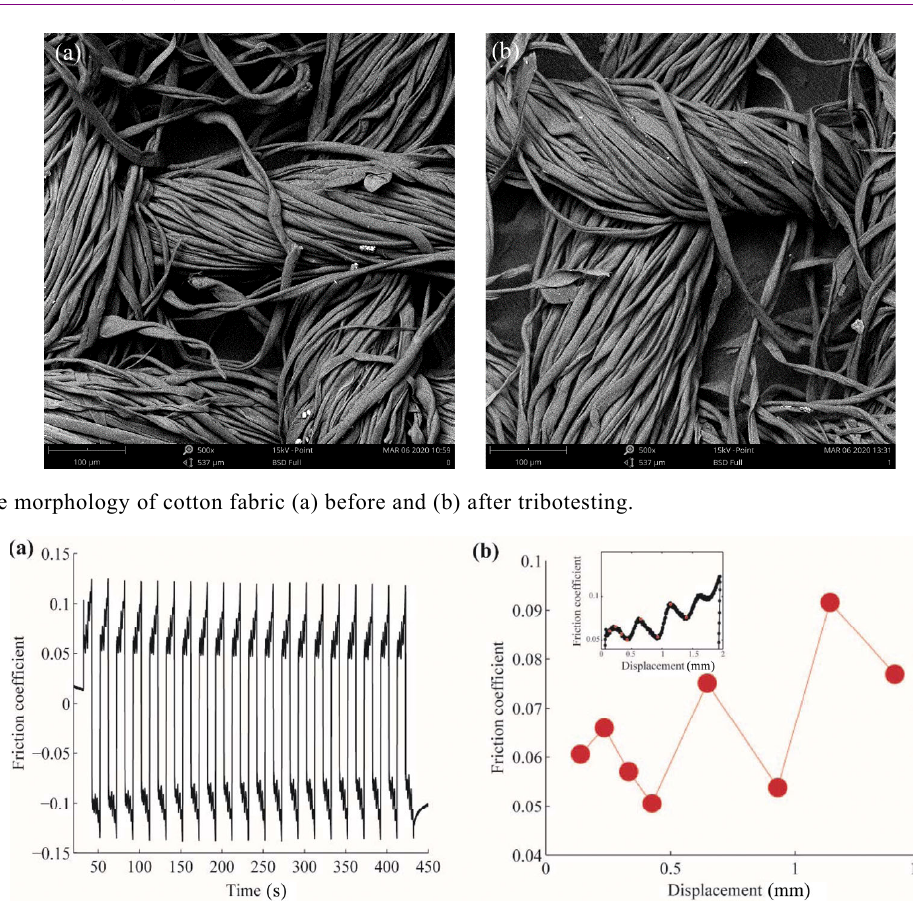
Fig. 6 Change in friction coefficient with (a) time and (b) displacement at a velocity of 0.2 mm/s and load of 3